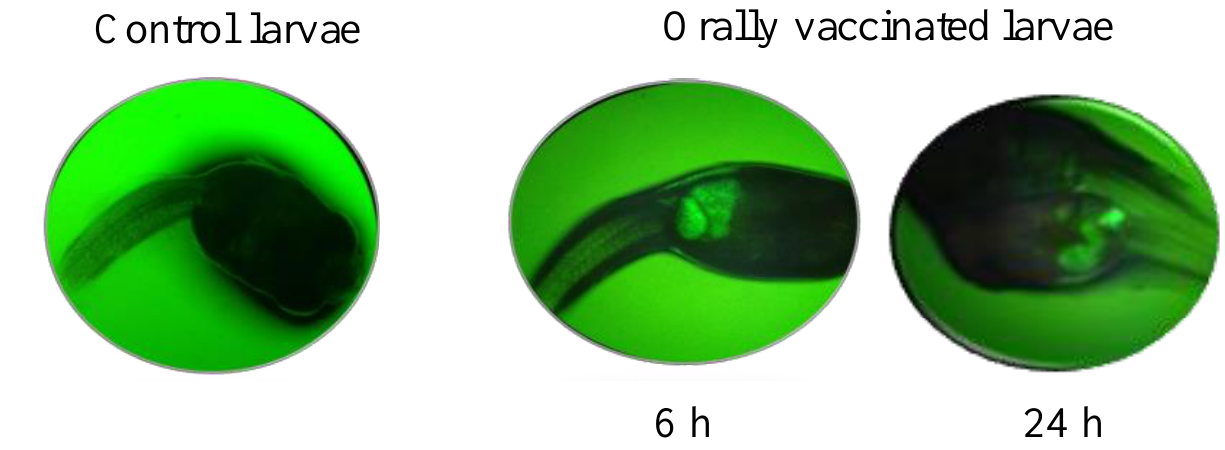
Figure 3. Selected images depicting the DTAF-labeled V. anguillarum bacterin bio-encapsulated in A. salina nauplii in the lumpfish gut after 6 and 24 h, visualized using epifluorescence microscopy. Its presence is indicated by green fluorescence.